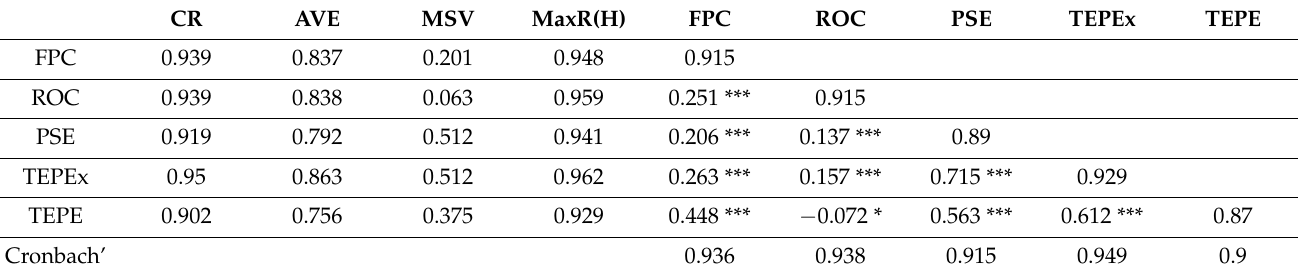
Table 6. Reliability and AVE Convergent Validity of Training in the General Domain ( n = 700).